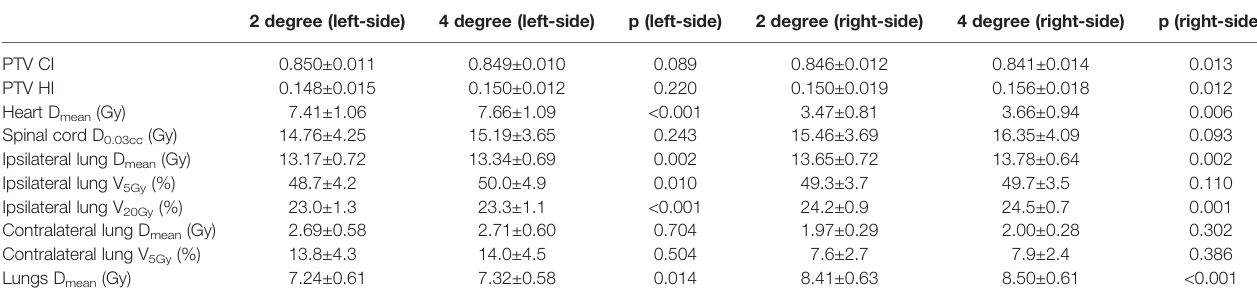
TABLE 8 | Dosimetric results (mean ± standard deviation) of postmastectomy VMAT plans with 2 degree and 4 degree gantry spacing